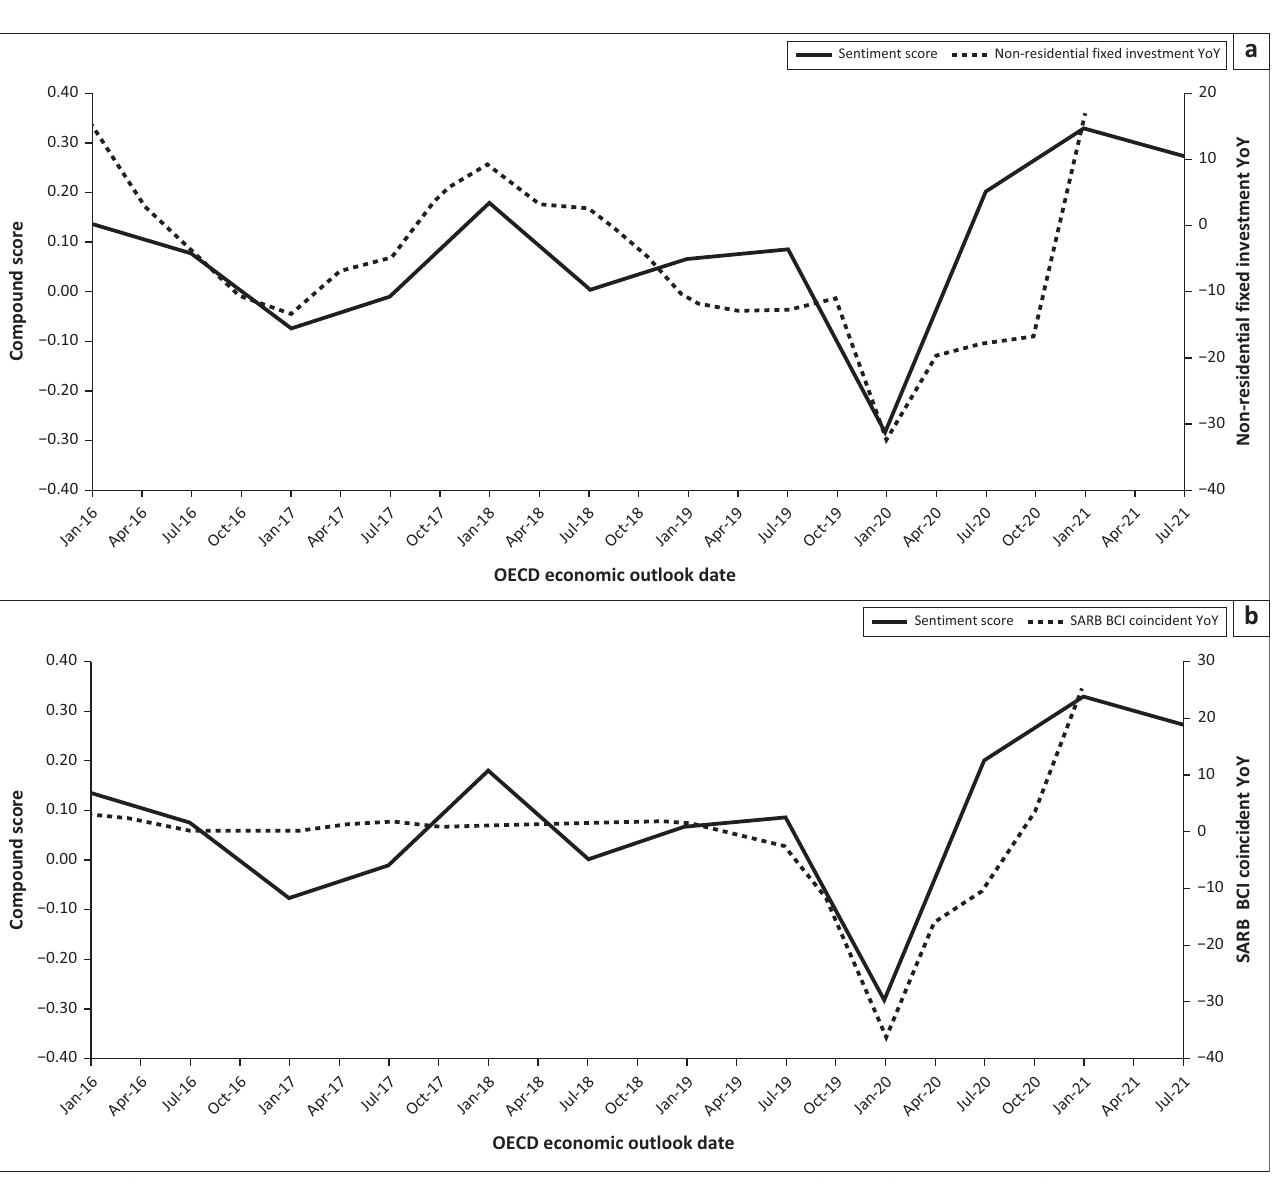
FIGURE 3: A comparison of the compound sentiment score derived with FinBERT from the Organization for Economic Co-operation and Development economic outlooks for South Africa from 2016 to 2021 and the observed BCI and NRFI variables, respectively (incorporating a 6-month lag)